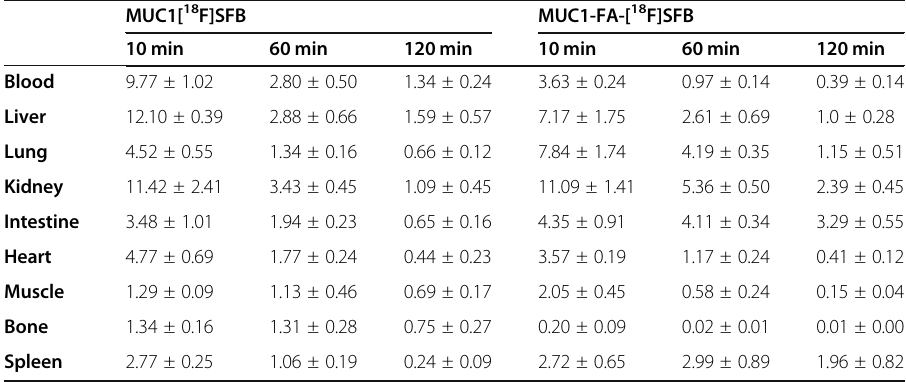
Table 1 Biodistribution of the MUC1[ 18 F] SFB and MUC1-FA-[ 18 F] SFB hybrid peptide conjugate in normal mice